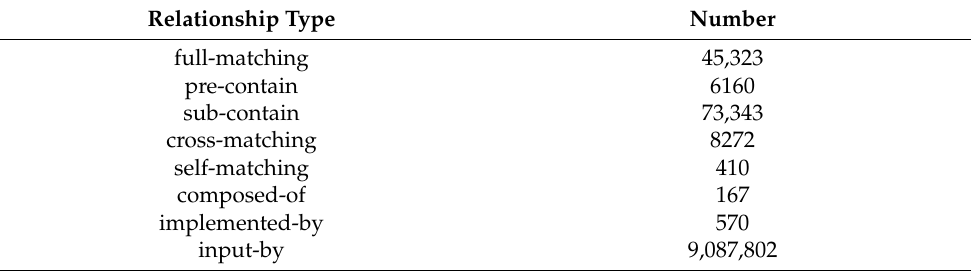
Table 3. Service relationships